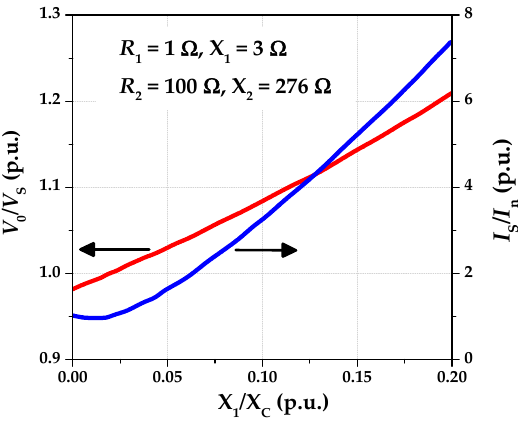
Figure 6. Output voltage and source current as a function of capacitance.